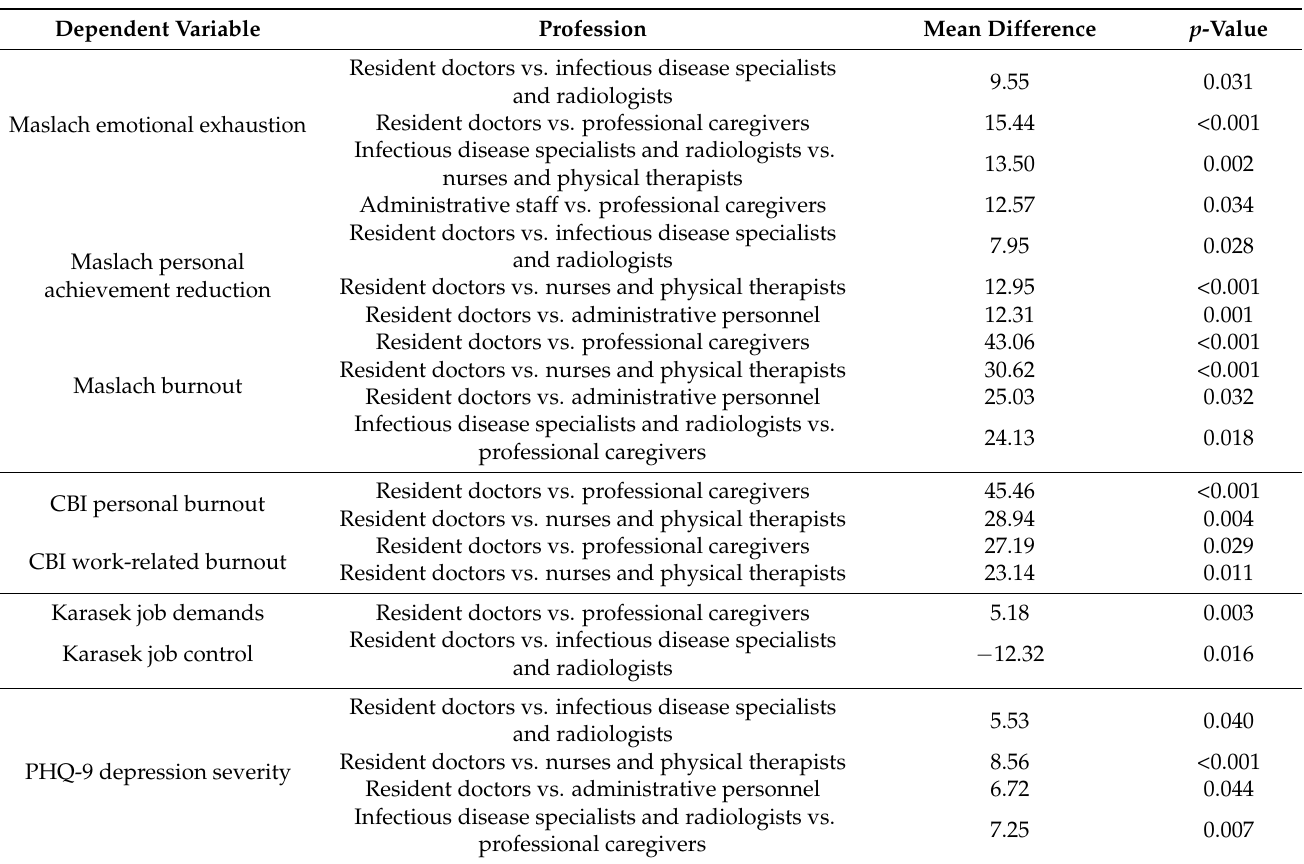
Table 5. Multiple comparisons of means between different professional